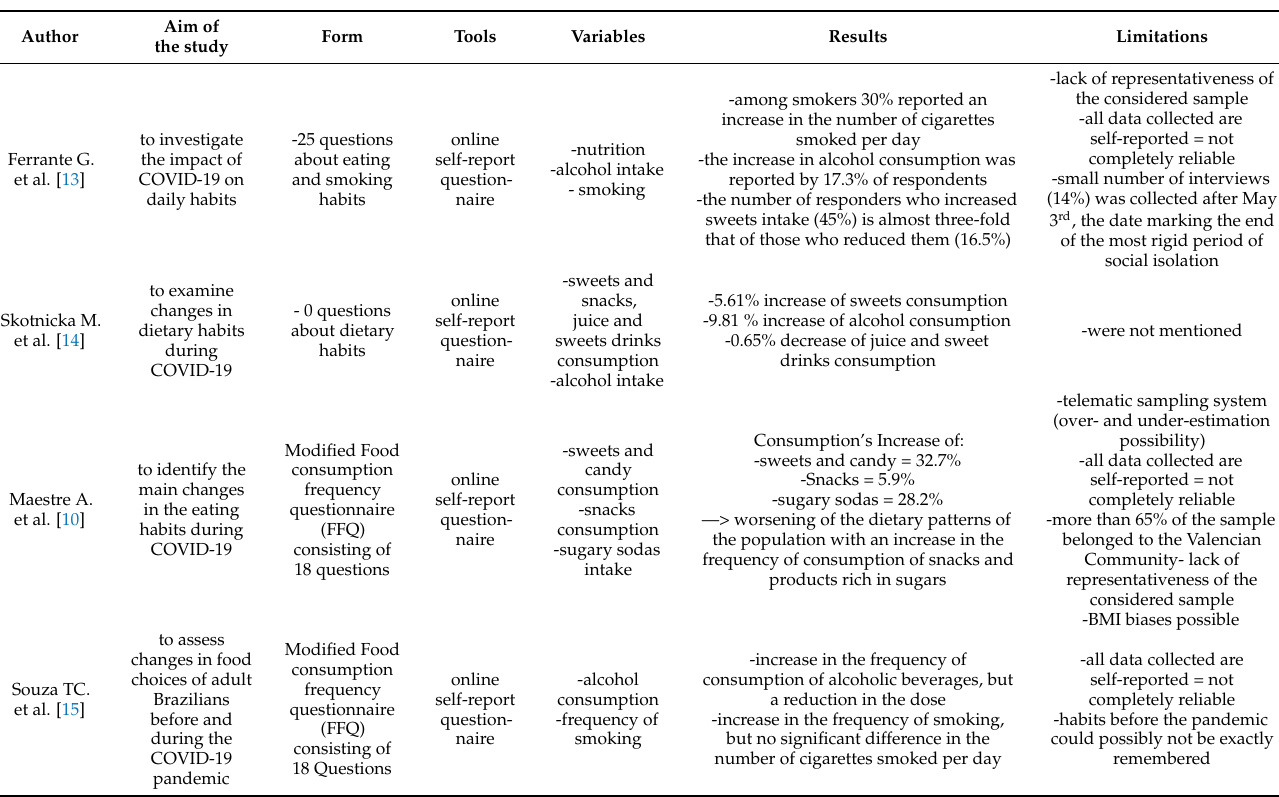
Table 4. The attributes of the involved